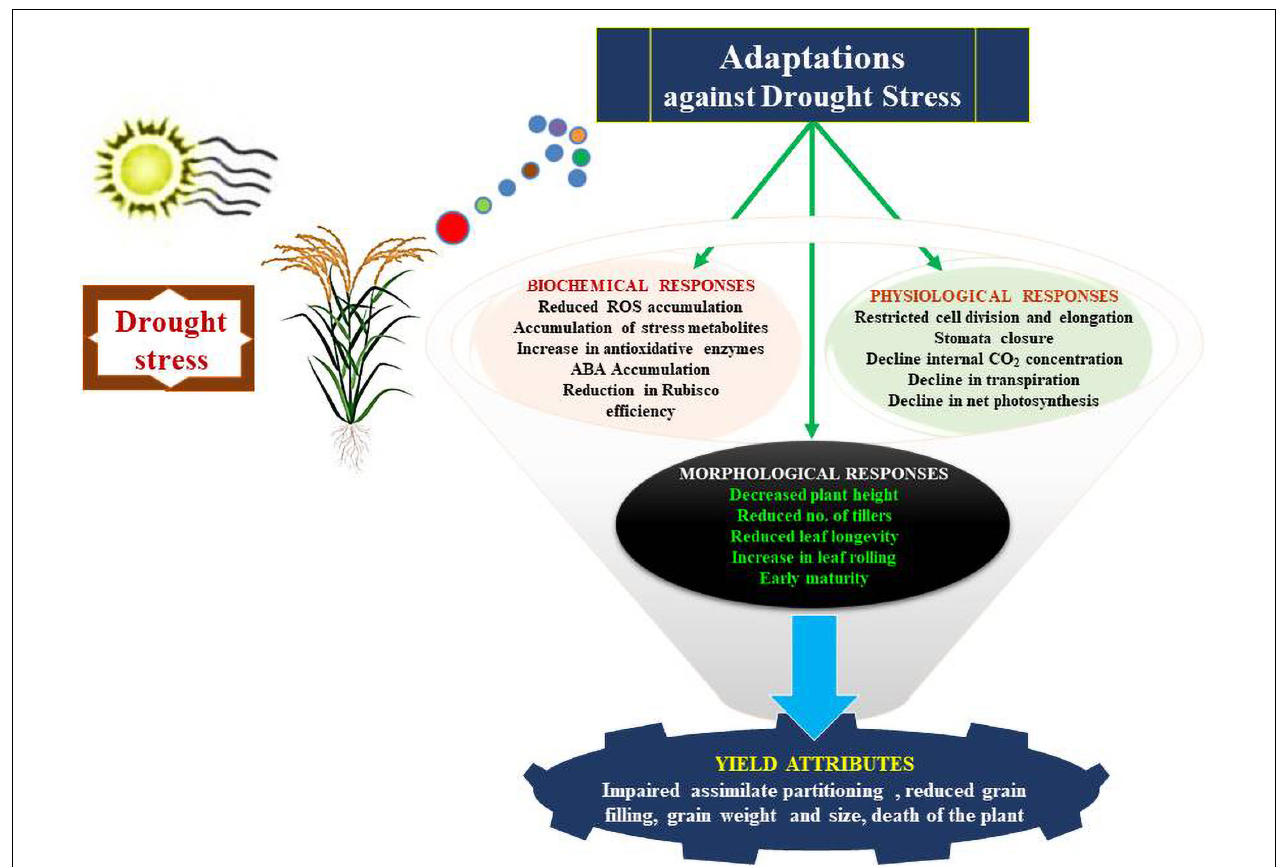
FIGURE 3 | Series of physiological responses that allow plants to adapt to environmental conditions that induce drought